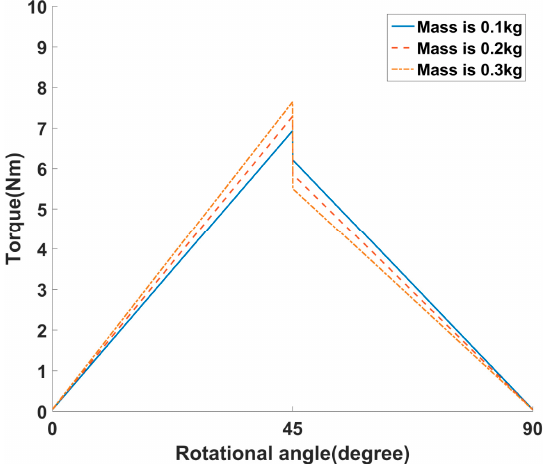
Figure 12. The input torques of the driving set at different masses.